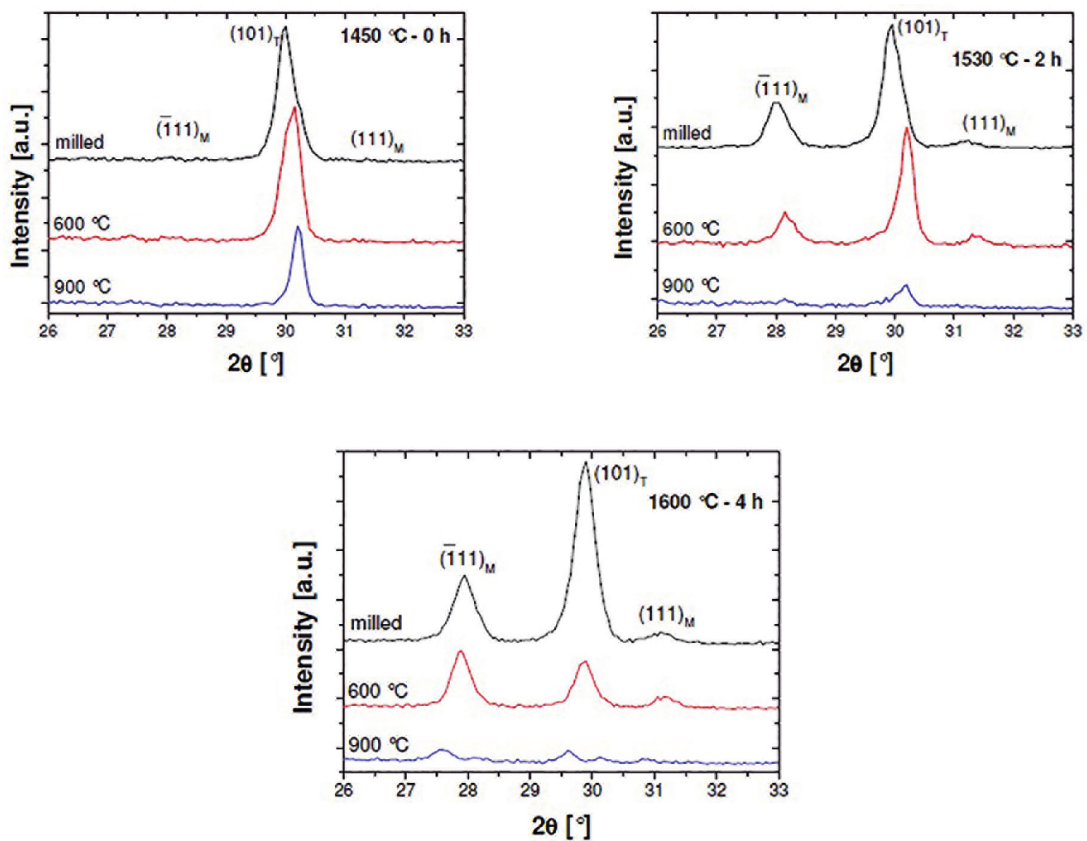
Figure 4: Representative XRD patterns of powder (crushed) samples before and after heat treatments.